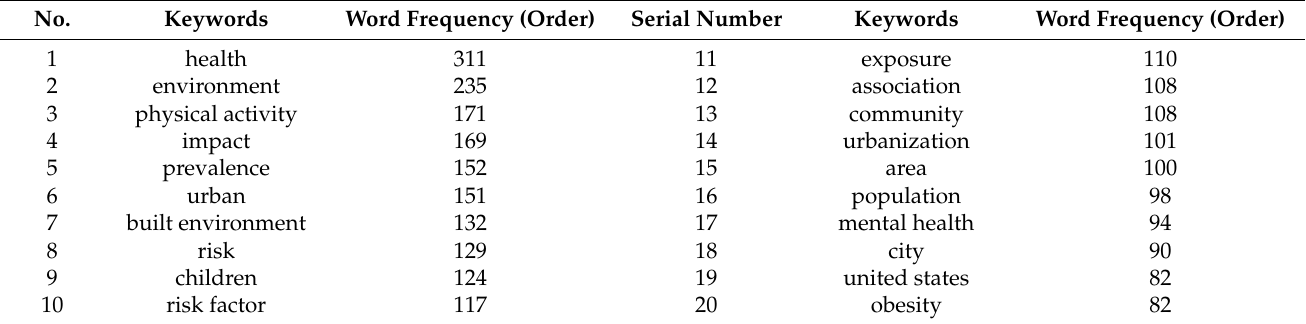
Table 7. High-frequency keywords statistics of rural human settlement environment